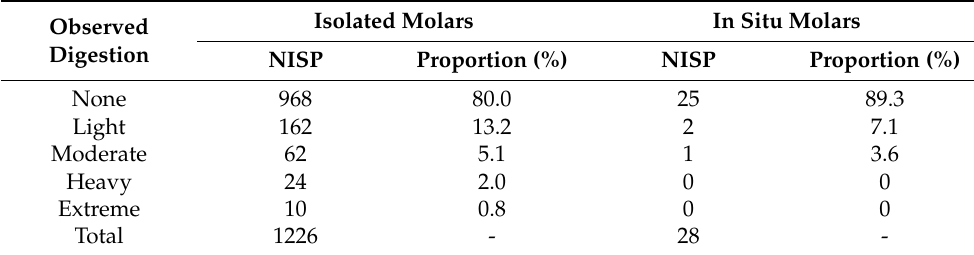
Table 6. Overall assemblage observed digestion of molars.